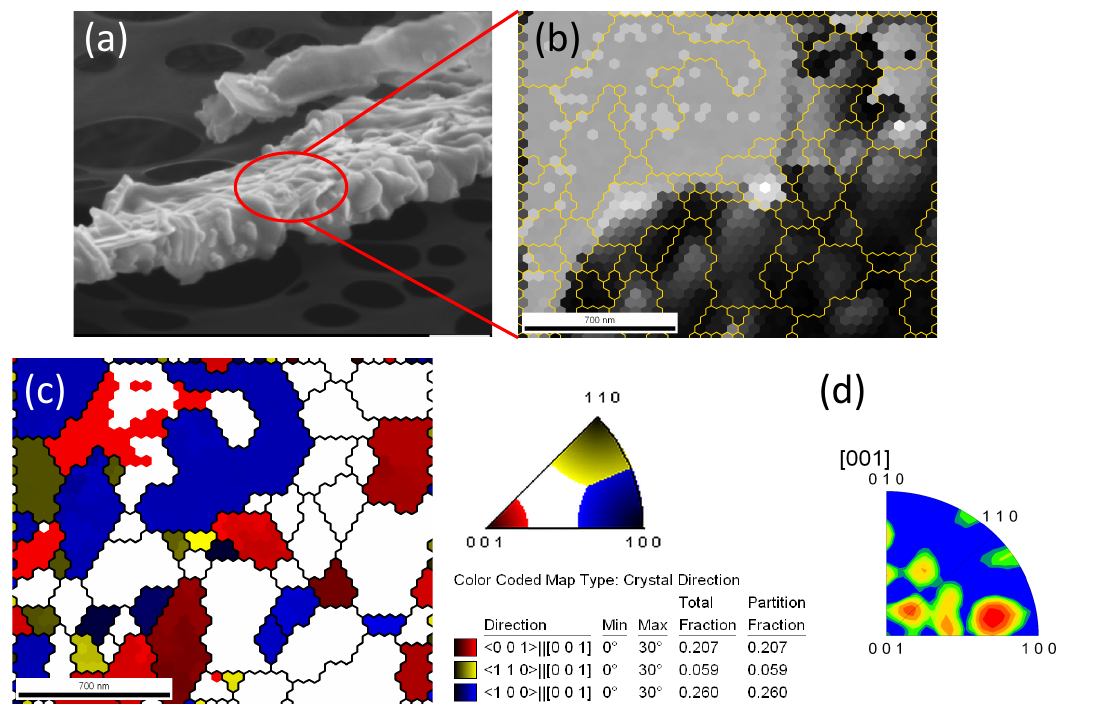
Figure 6. Electron backscatter diffraction (EBSD) analysis within an individual nanowire. These images can be directly compared to the TEM images shown in Figures 4 and 5. ( a ) gives a nanowire section in an SEM-image under 70 ◦ inclination. The area within the red circle is analyzed by EBSD. ( b ) shows an image-quality (IQ) map of the analyzed area, with the detected grains marked in yellow. ( c ) presents a crystal direction mapping in (001) direction, that is, the orientation is given perpendicular to the sample surface. The direction TD corresponds thus to the nanowire surface. The color code for the map is given on the right side; the grains not fitting to 30 ◦ around the poles are plotted in white. ( d ) shows the inverse pole figure in